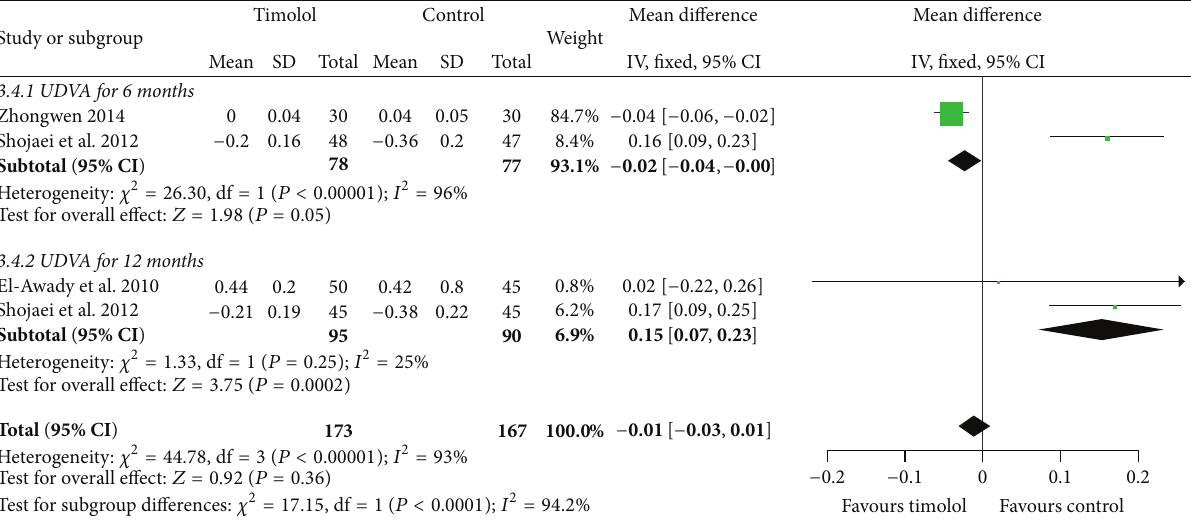
Figure 6: Comparison of logMAR UDVA between the two groups in different time.